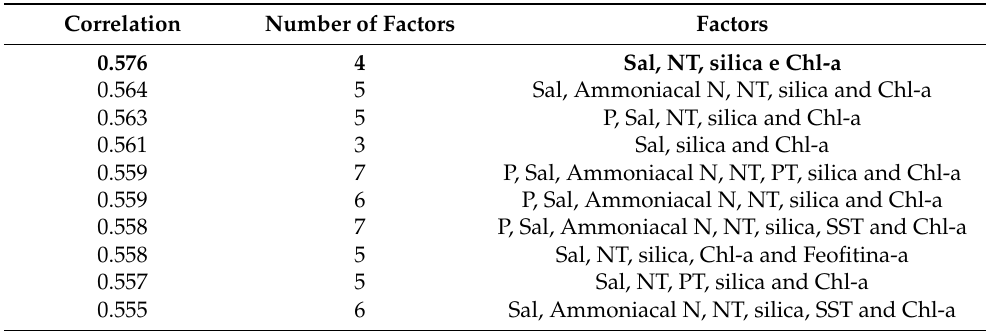
Table 3. BEST (BIO-ENV stepwise) test results in Piranji Estuary (equatorial Southwestern Atlantic, Brazil, 2015). Sal: salinity; P: depth; ammoniacal nitrogen: N-NH 3 ; total nitrogen: NT; total phosphorus: PT; total suspended solids: TSS; chlorophyll a: Chl a .